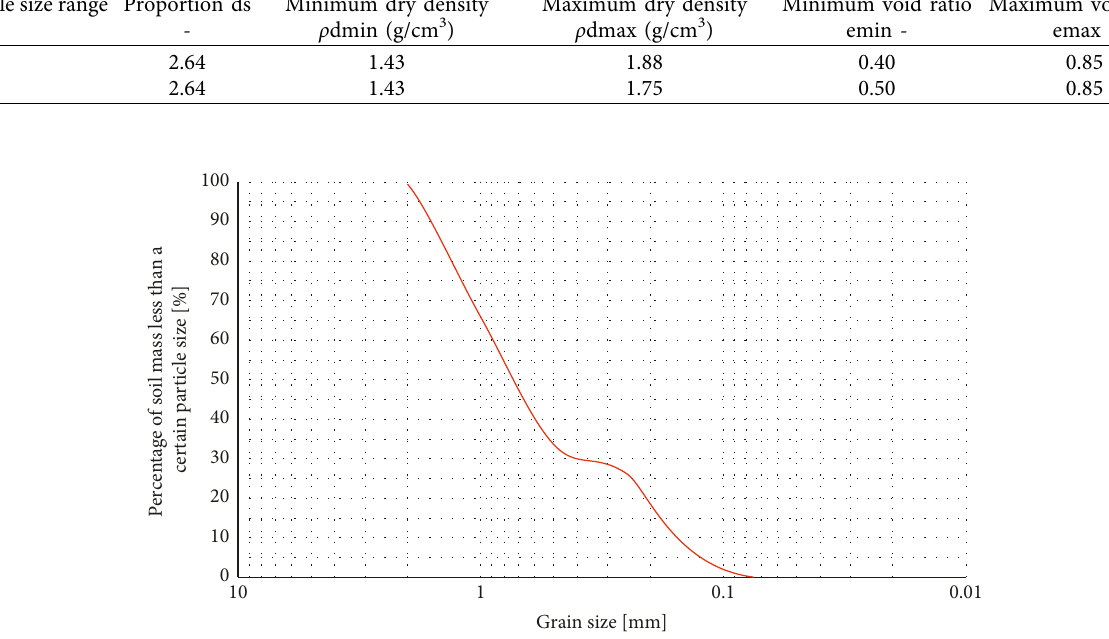
Figure 1: Grading curve of Fujian standard